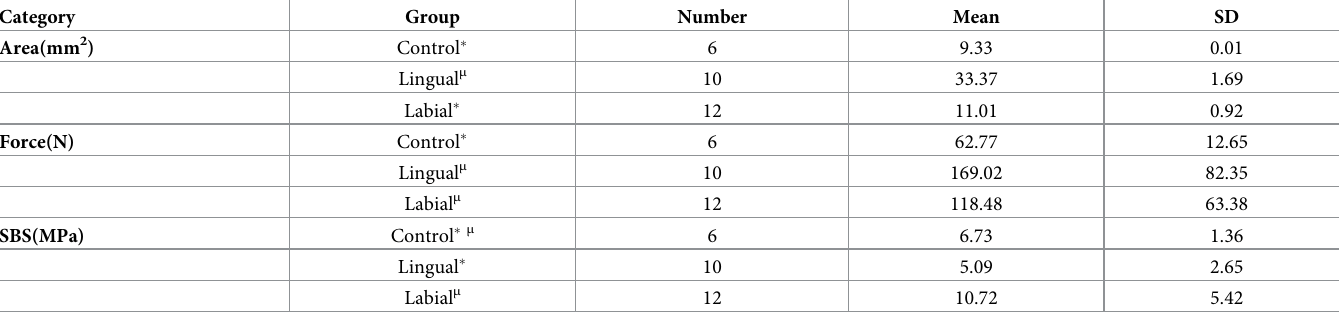
Table 3. Comparison of area, debonding force and shear bond strength between the control, lingual and labial brackets. Category Group Number Mean SD Area(mm 2 )